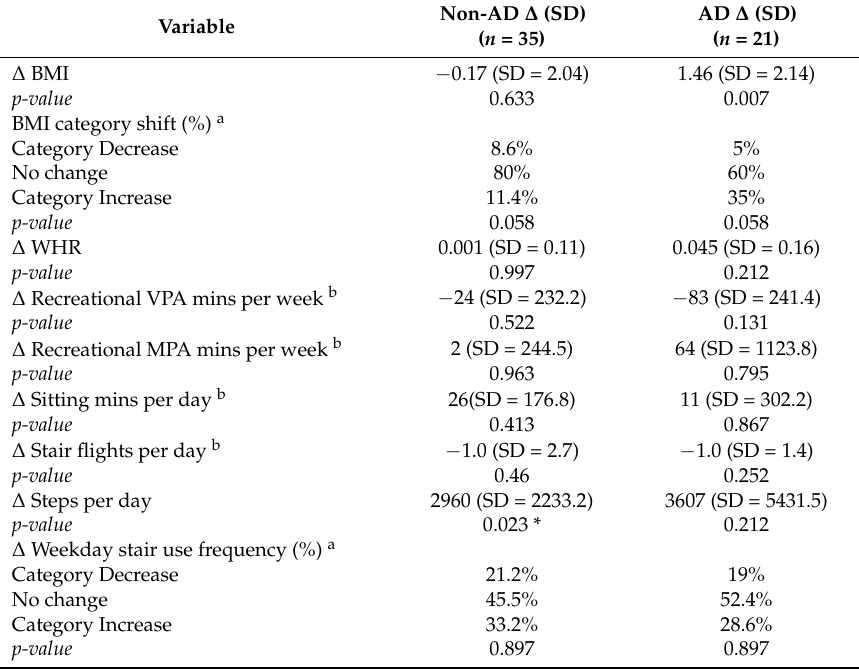
Table 2. Pre-Post Paired Comparisons for Anthropometric and Physical Activity Response Variables.